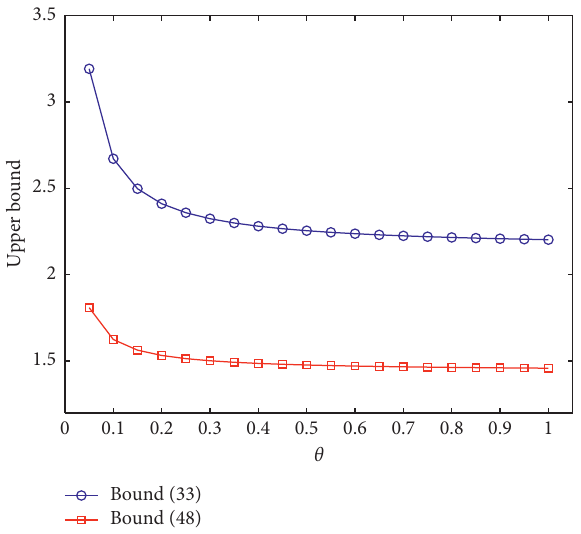
Figure 5: Bound (33) and bound (48) as a function of θ